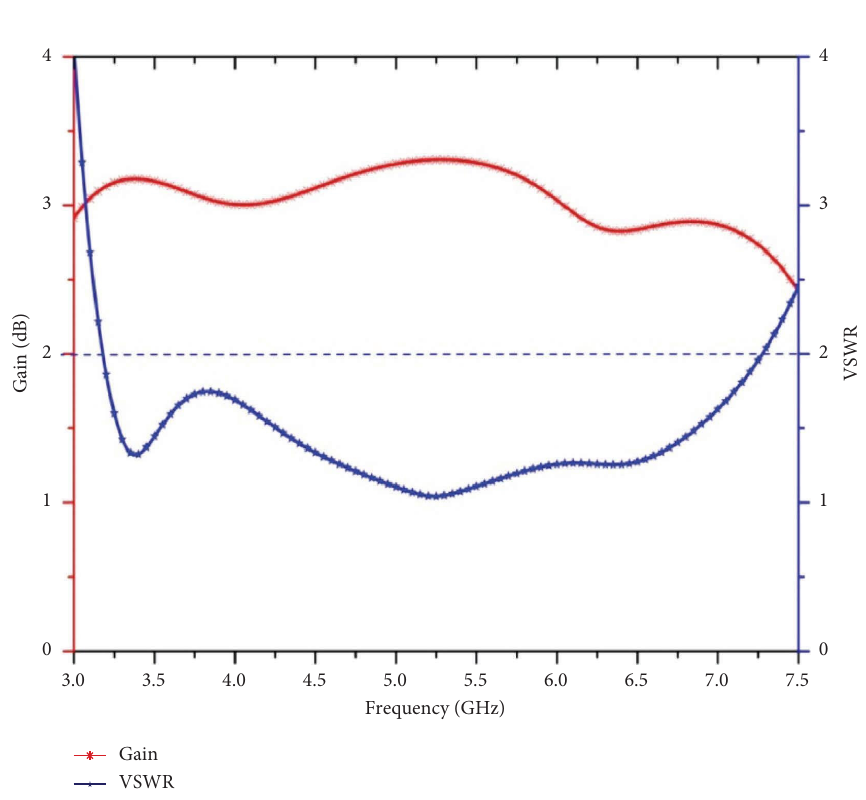
Figure 2: Return loss and axial ratio.